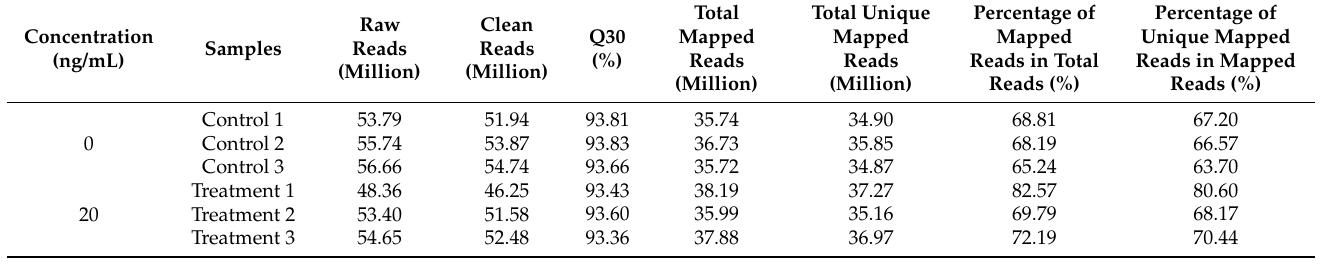
SDF1 treatment groups.